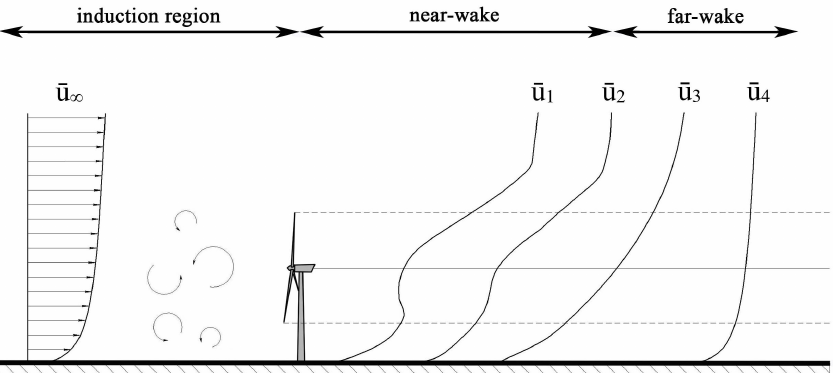
Figure 1. A diagram of the movement of air masses in the area of the wind turbine, showing the flow areas resulting from the interaction of the wind turbine and the incoming turbulent boundary